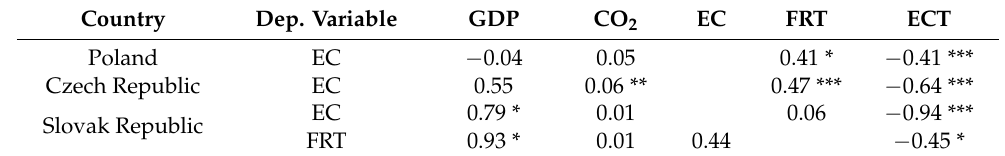
Table 6. Long-run